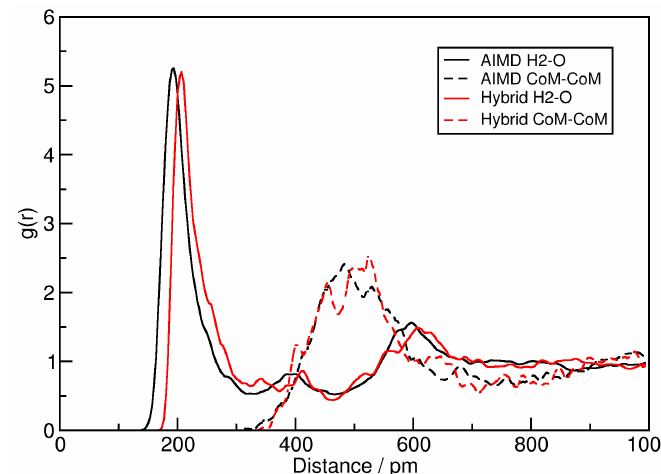
Figure 3. Radial distribution functions (RDFs) between [EMIm] + H2 and [OAc] − O (solid lines) and between cation and anion mass centers (dashed lines) of the ionic liquid [EMIm][OAc] from the standard ab initio molecular dynamics (AIMD) simulations (black lines) [59–61] and the HyAIMD simulations performed here (red